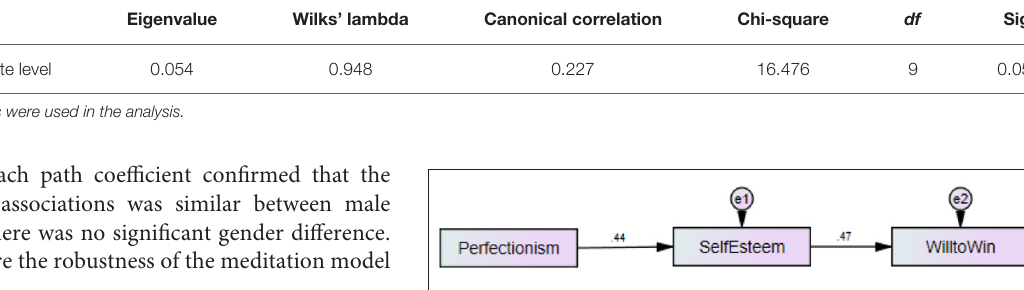
FIGURE 1 | Path model depicting direct and indirect relationships between perfectionism, self-esteem, and the will to win.